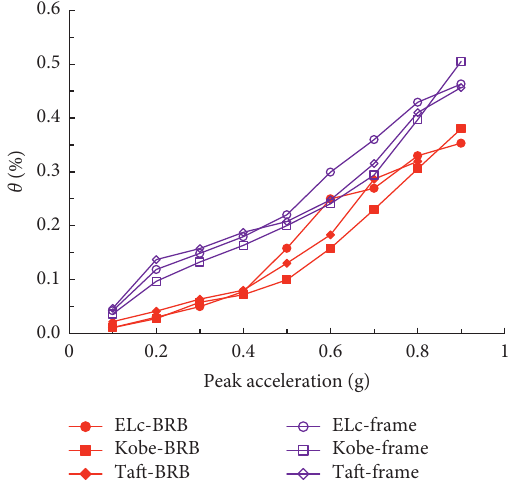
Figure 16: Interstory drift ratios of the specimen under different